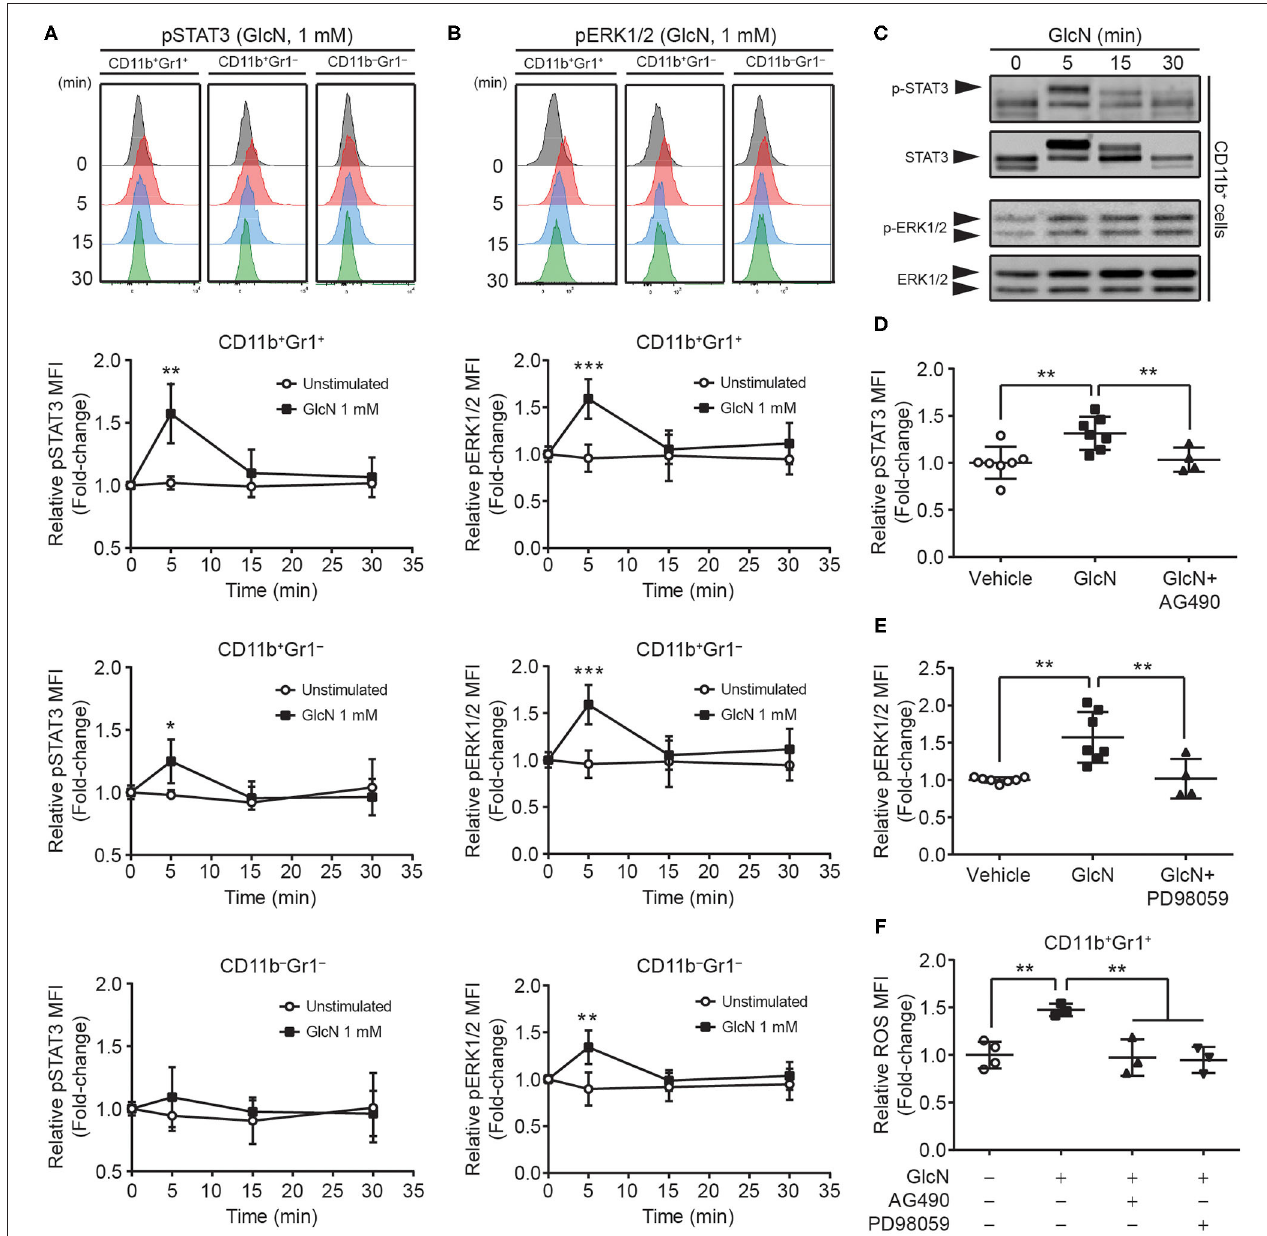
FIGURE 8 | GlcN stimulates the activation of STAT3 and ERK1/2 in MDSCs. The level and mean fluorescence intensity (MFI) of (A) phosphorylated STAT3 (pSTAT3) and (B) phosphorylated ERK1/2 (pERK1/2) in BM CD11b + Gr1 + , CD11b + Gr1 − , and CD11b − Gr1 − cells were shown. (C) The levels of phospho-STAT3, STAT3, phospho-ERK1/2 and ERK1/2 in GlcN-treated CD11b + cells were detected by Western analysis. (D) JAK2 inhibitor AG490 and (E) MEK inhibitor PD98059 were used to suppress GlcN-induced phosphorylation of STAT3 and ERK1/2 proteins, respectively, in BM CD11b + Gr1 + cells. (F) Inhibition of either STAT3 or ERK1/2 decreased GlcN-promoted ROS production in CD11b + Gr1 + MDSCs. Quantified results are presented as the mean ± standard deviation. * P < 0.05; ** P < 0.01; *** P < 0.001. differentiation and myelopoiesis. We also demonstrated